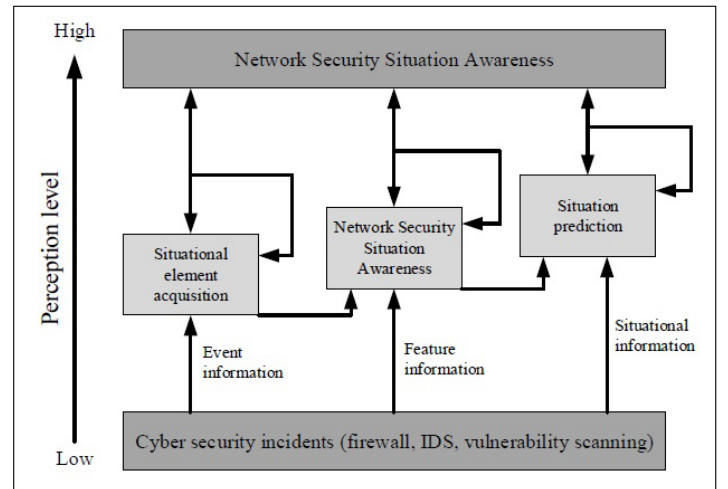
Fig. 1 Network security situation awareness